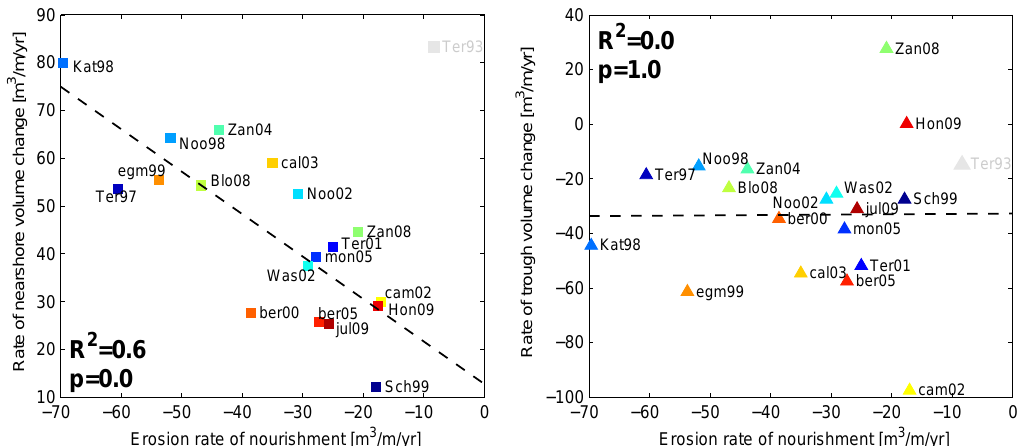
Figure 10. Correlation of erosion rate of the nourishment region with the rate of nearshore accretion and erosion of the trough